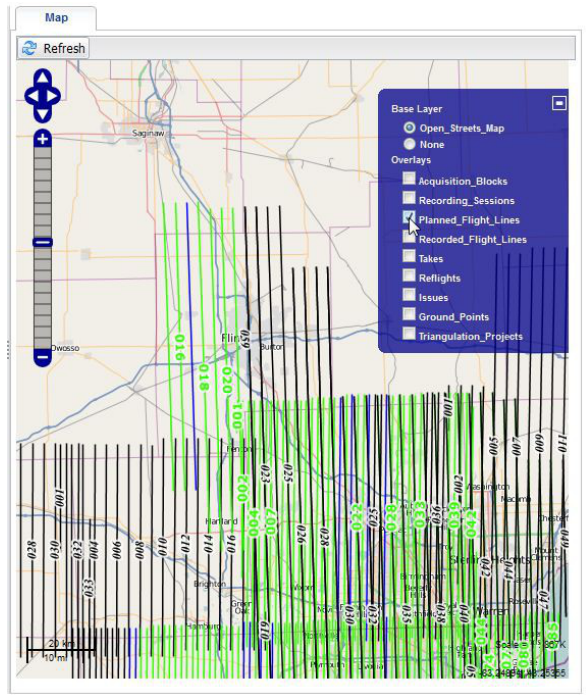
Figure 5: Recorded flight lines